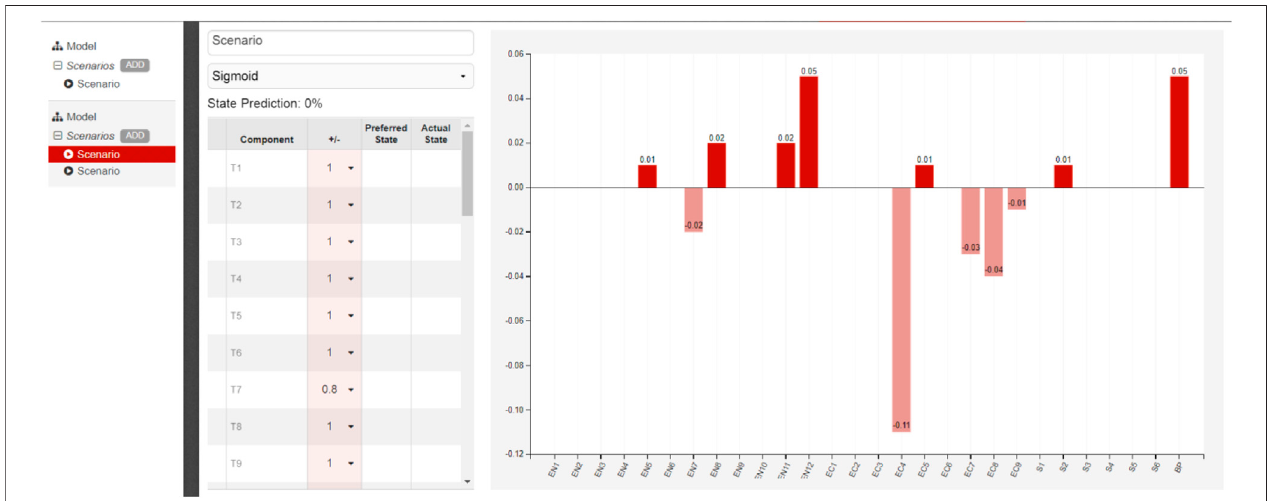
FIGURE 6 | Best case scenario for the Schizochytrium limacinum sp with sigmoid learning and for the impact of the technological criteria.